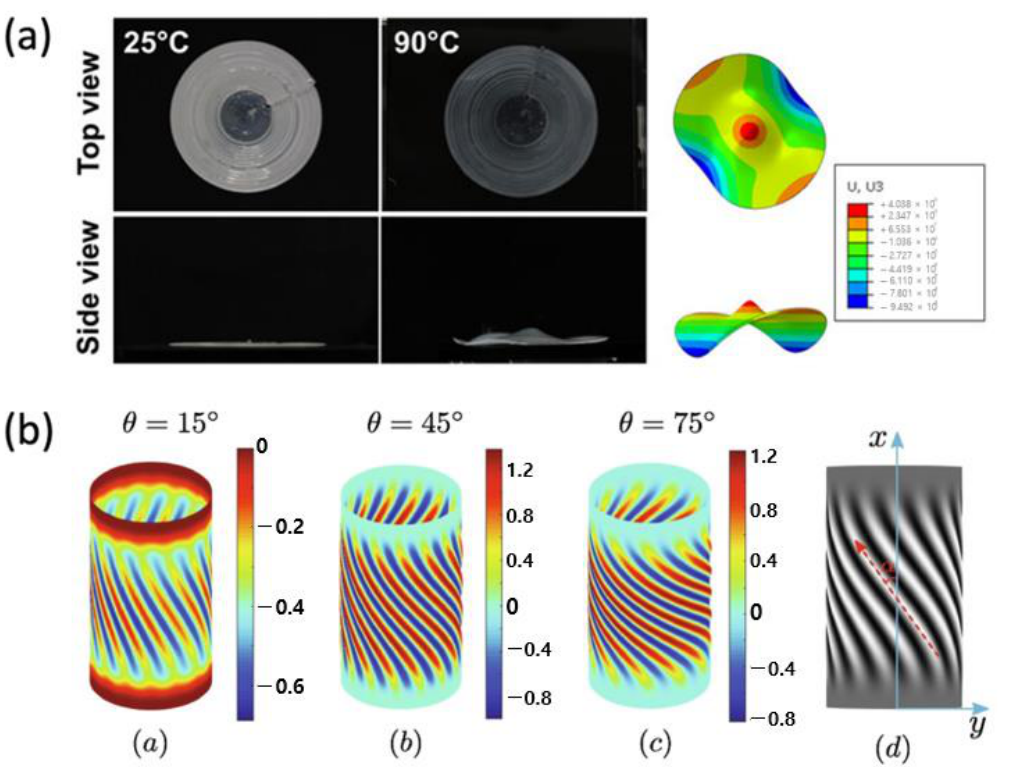
Figure 12. Structural instability observed in ( a ) 3D-printed LCN disk (Adapted with permission from Ref. [12]. 2020, Wang, Z et al.) and ( b ) oblique angle ( α ) oriented LCN cylinder depending on different θ , which affects shear stress (Adapted with permission from Ref. [97]. 2021, Zhao, S et al.).